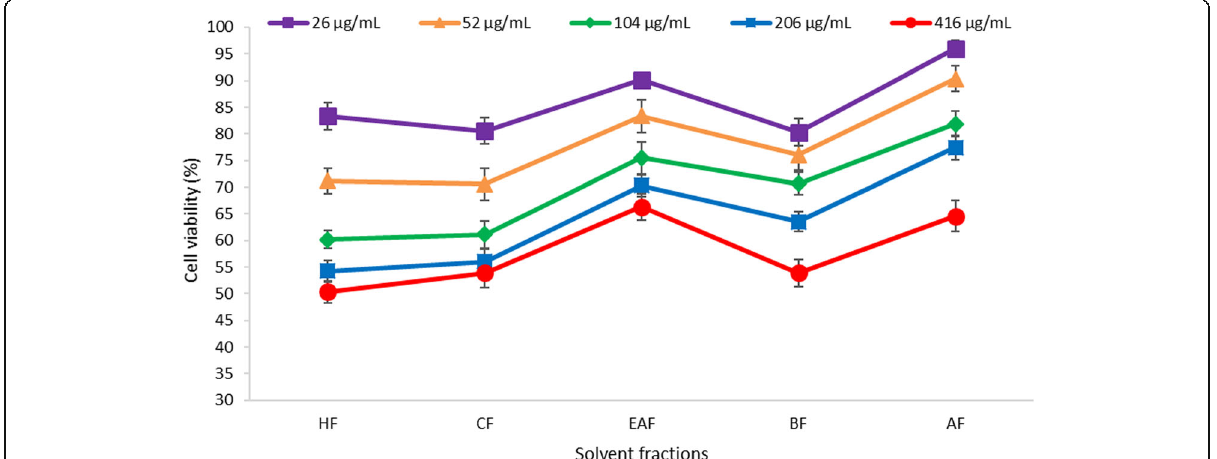
Fig. 1 Cytotoxic effect of Moringa oleifera leaves extracts of various solvents viz . n-hexane, chloroform, ethyl acetate, butanol, and water on Hela